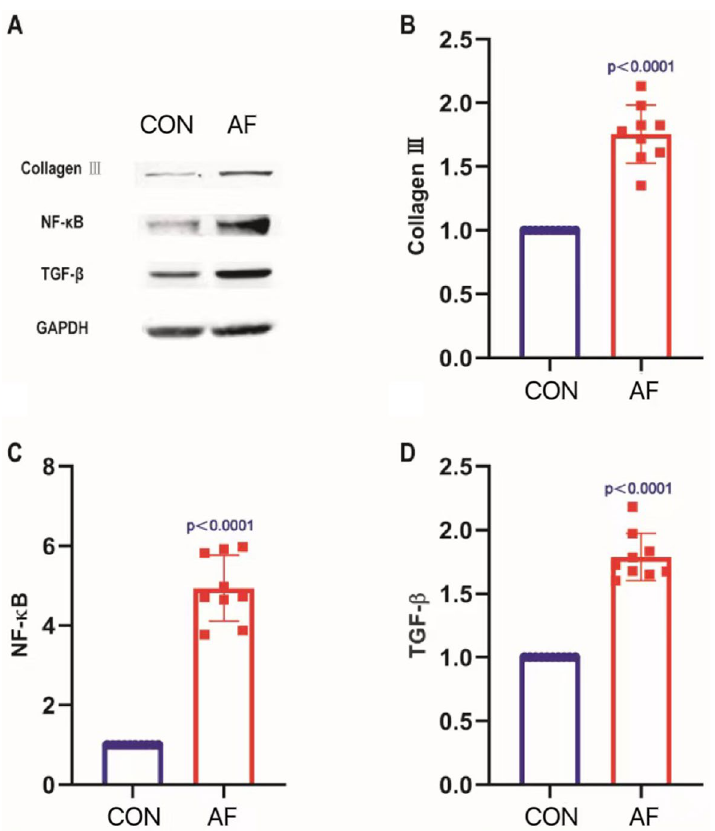
Figure 3. Inflammation and collagen production in mice kidney were increased in AF. ( A ) Results of Western blotting detecting Collagen III, NF-κB and TGF-β expressions in kidneys in CON and AF. ( B ) Comparison of the expression of Collagen III in kidneys in CON and AF. ( C ) Comparison of the expression of NF-κB in kidneys in CON and AF. ( D ) Comparison of the expression of TGF-β in kidneys in CON and